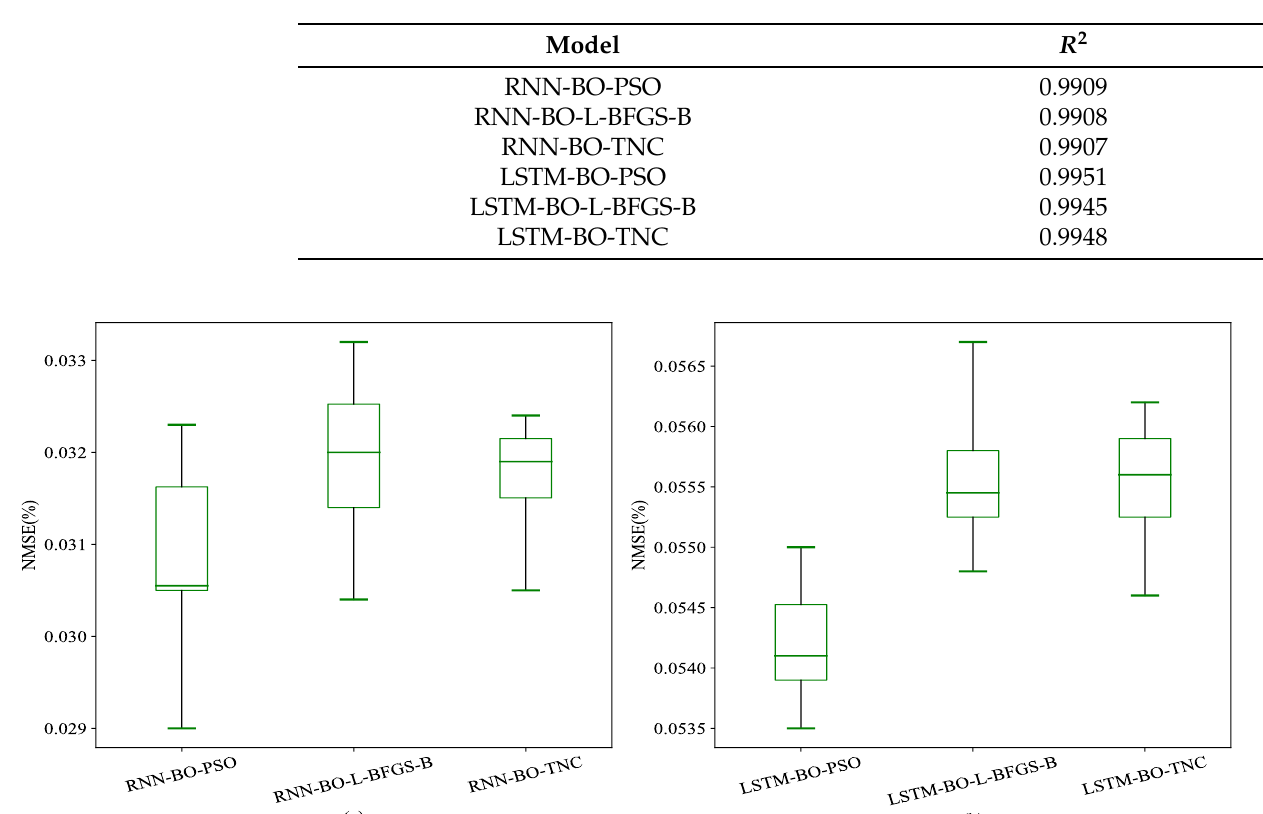
Table 2. The value of R 2 for different models.